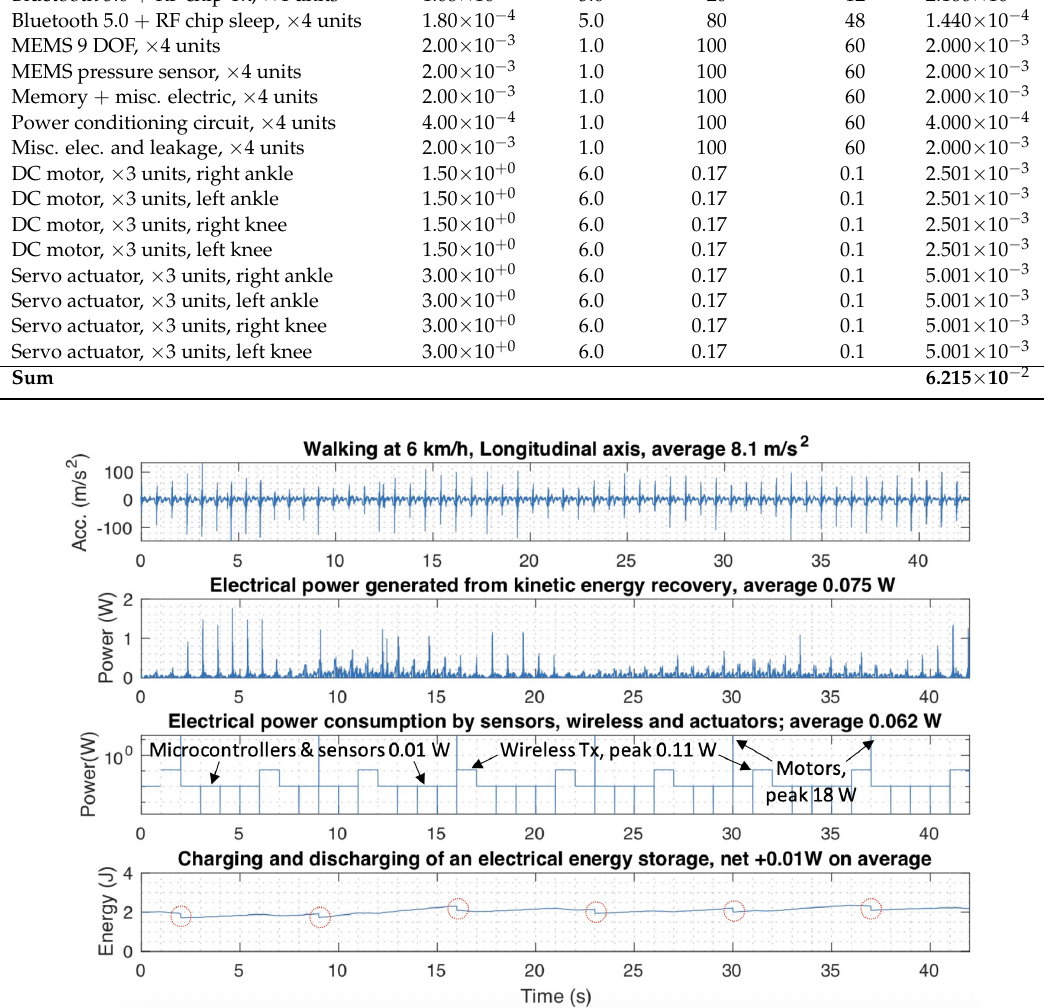
Figure 9. Simulated charging and discharging of an energy storage by energy recovery and electrical load, respectively, for a walking scenario. A starting energy of 2 J is given within the